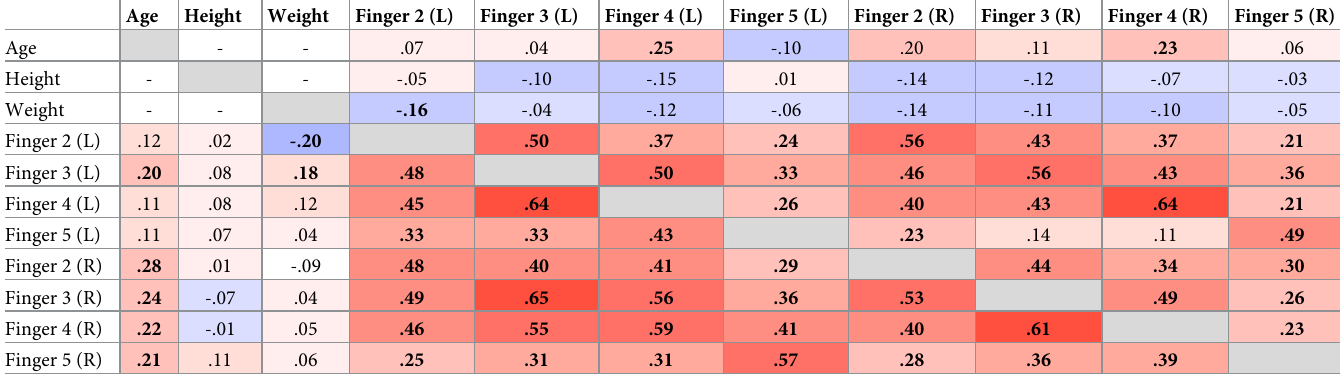
Table 1. Correlations for tapering among fingers and between fingers and other variables.